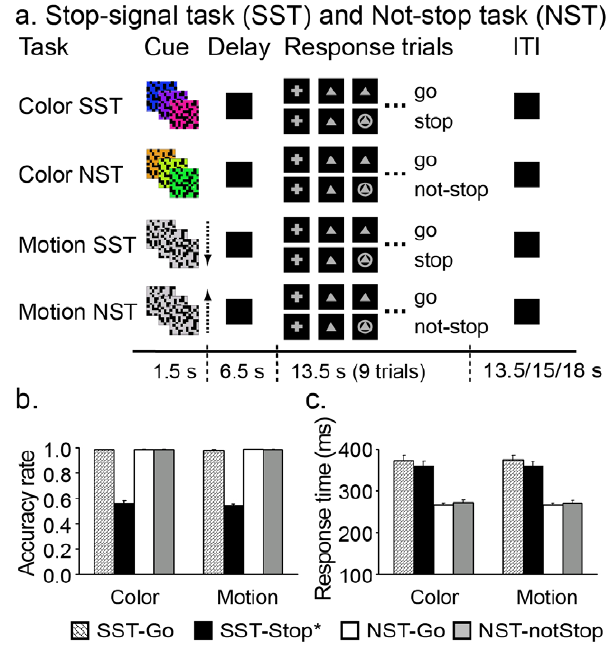
Figure 1. Behavioral tasks and behavioral data. a, A schematic diagram of the task conditions. The present experiment included two visuomotor tasks - a stop signal task (SST) and a not-stop task (NST). Each task was cued by a color and a motion stimulus, forming a total of 4 conditions (color-SST, color-NST, motion-SST and motion-NST). There were three task epochs: cue, delay and a block of response trials. A visual cue (color or motion) was presented at the beginning to indicate the current rule for the response epoch (SST or NST). After a 6.5-sec delay (black screen), a warning signal was presented for 1 sec (not shown) followed by a block of 9 response trials. For both tasks, a go signal was presented on every trial that was occasionally followed by a stop signal (circle) at variable delays (see Methods). Subjects were told to try their best to withhold their response in the presence of the stop signal for the SST but to ignore it (and make their response) for the NST. The inter-task interval varied between 13.5, 15 and 18 sec. b, Average response accuracies for go (SST-Go) and stop (SST-Stop) trials in the SST and go (NST-Go) and not-stop (NST-NotStop) trials in the NST by cue type. c. Average response times across trial types. *SST-Stop refers to all stop trials in b and unsuccessful stop trials in c.